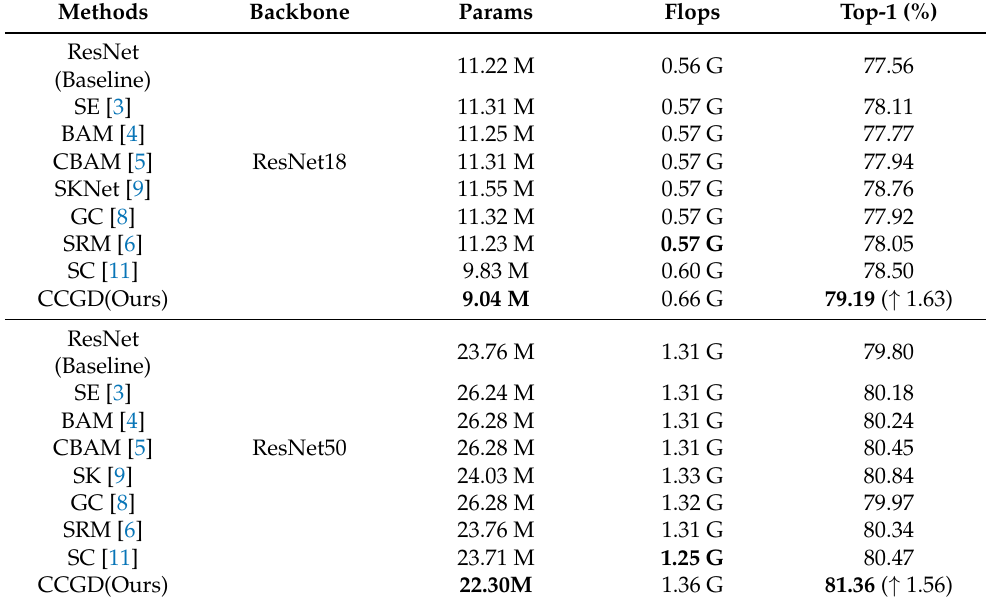
Figure 4. The results of using CCGD on Cifar100 dataset with ResNet and ResNetXt backbone. Table 1. The results of using different attention-based methods on Cifar100 dataset with ResNet backbone. Results in bold are the best in each column with the same backbone. ↑ means the increase from